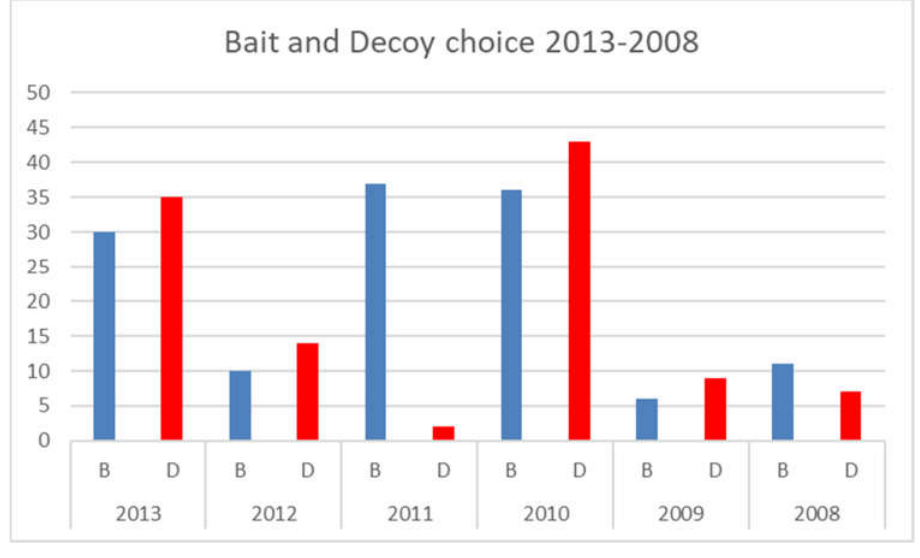
Figure 3. Bait and seal-shaped decoy shark choice, between 2013 and 2008 . Table 2. Pearson’s Chi-squared test of independence. The first column denotes the sub-categories, and the second column displays the corresponding statistical results in terms of p -values. The significant codes are as follows: * significance at 10%, ** significance at 5%, and *** significance at 1%.